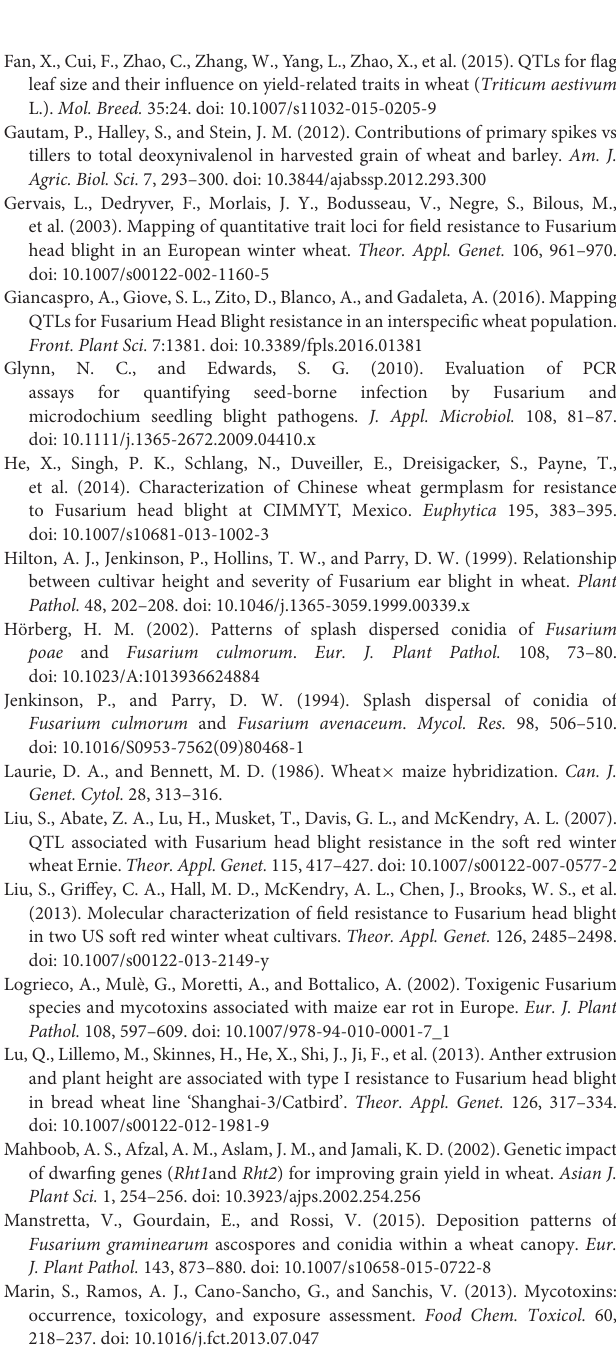
Supplementary Table 1 | Trait means for genotypes from individual